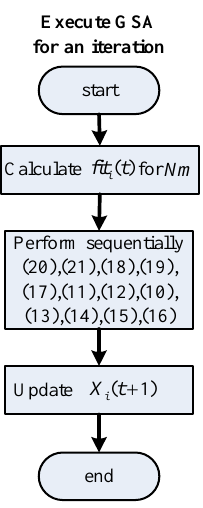
Figure 6. Flowchart for executing the GSA for an iteration.